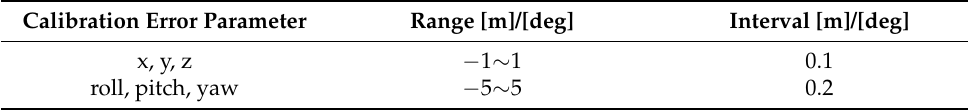
Table 4. Calibration parameter error configuration.